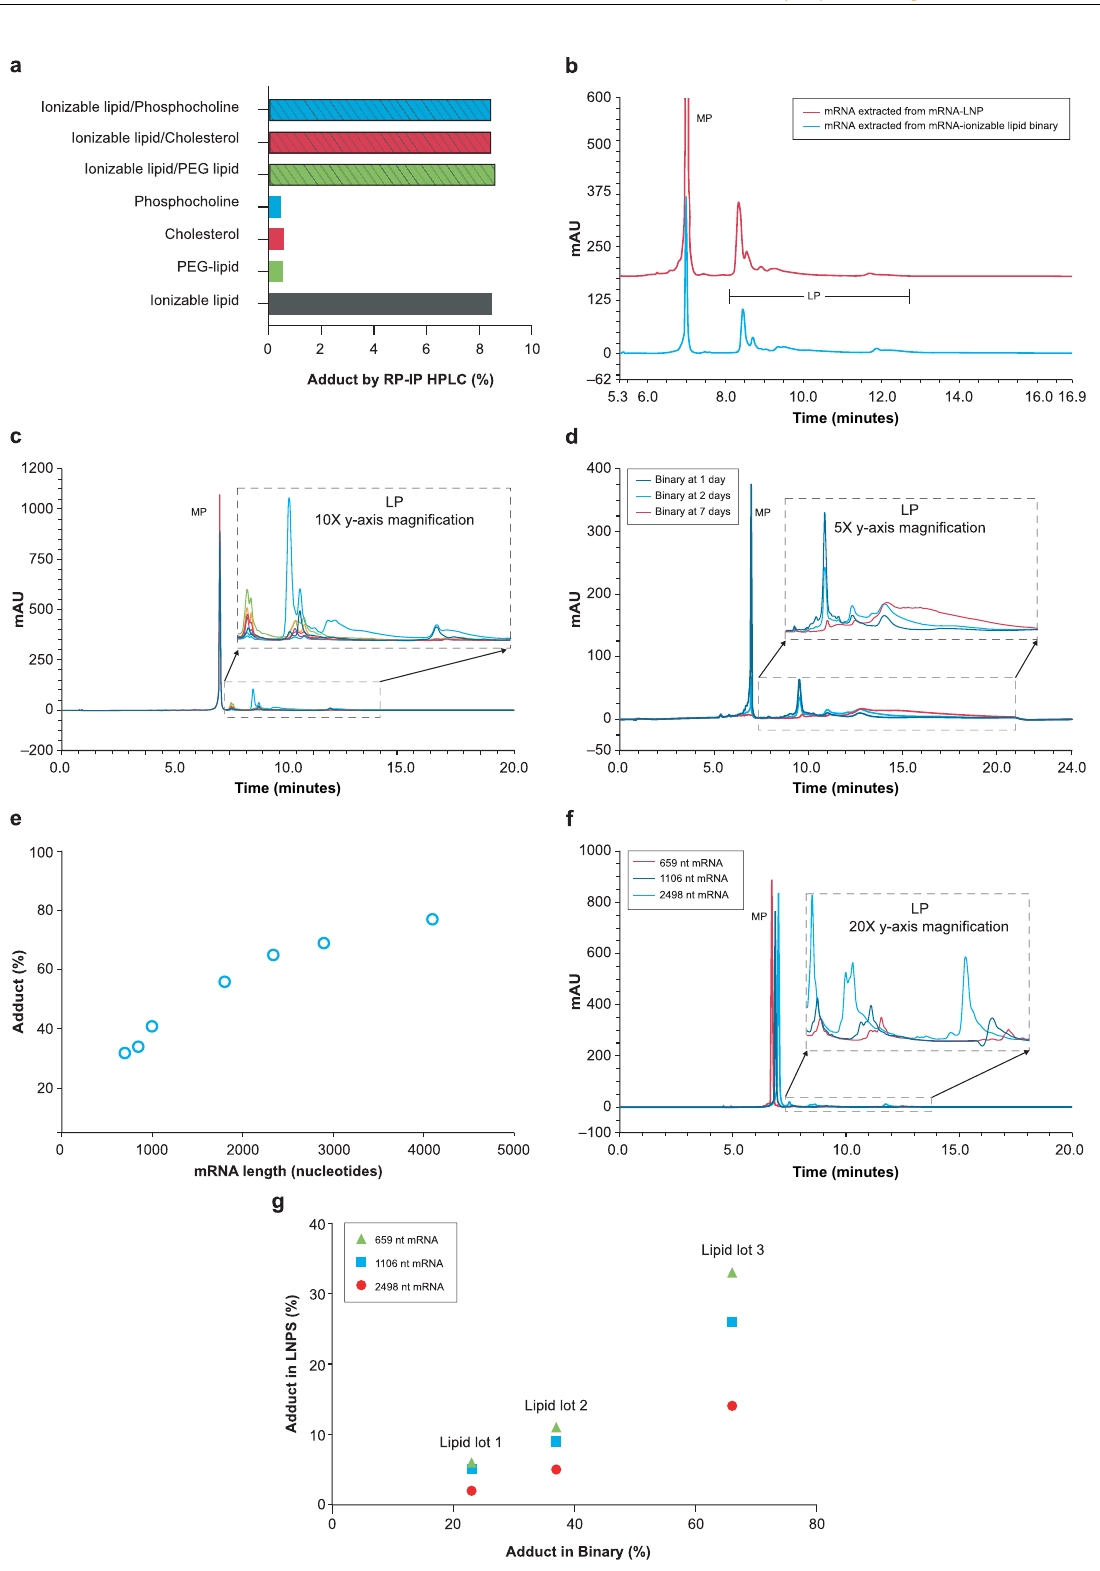
was assessed using RP-IP HPLC, a correlation between relative mRNA integrity (including the adduct as an impurity) and pro- tein expression was found (Fig. 6b). In contrast, mRNA integrity measured by CE only weakly correlated with protein expression; all samples had a narrow range of relative purity despite the decrease in protein expression (Fig. 6b). Extrapolating